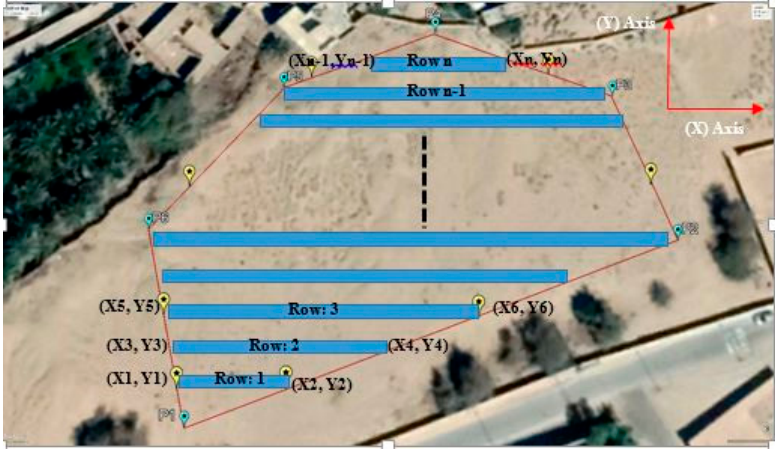
Figure 7. Arrangement of PV modules according to PV plant shape.